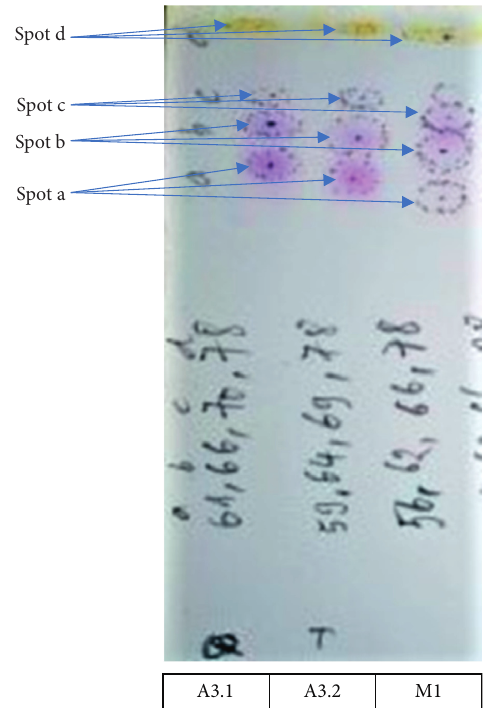
Figure 5: HPTLC of A3.1, A3.2 (39-month-old), and M1 (50- month-old) developed in system B—ethyl acetate/ethanol/water (26:13:11v/v).